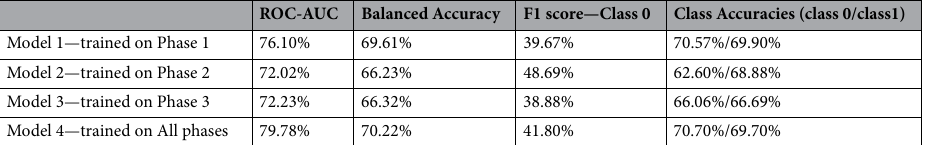
Table 4. Clinical trial early termination classification results trained using phase specific (Phase 1, Phase 2, Phase 3 and all phases) subsets. Evaluation metrics include ROC AUC (Receiving operating characteristic Area Under the Curve), balanced accuracy, F1 score for class 0 and class specific accuracies (class 0/ class